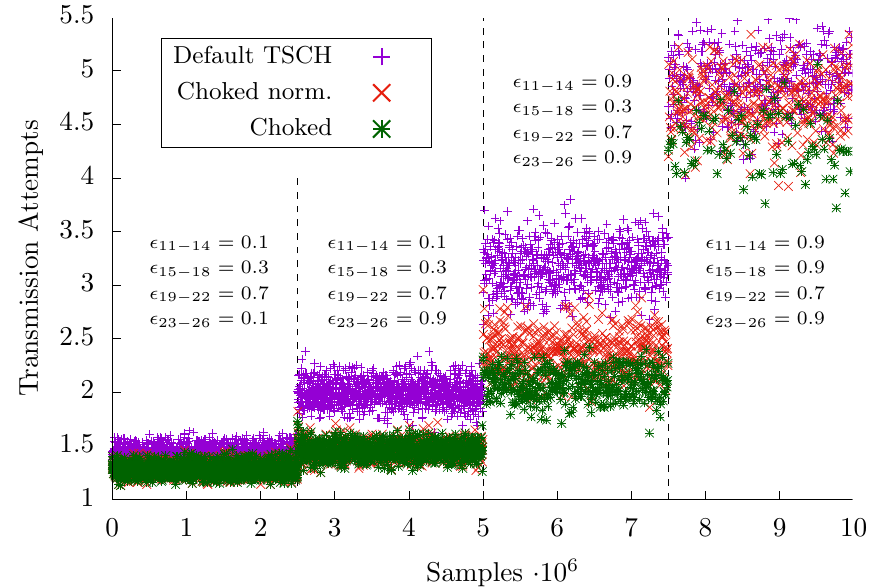
Figure 5. Number of transmission attempts per frame vs. time